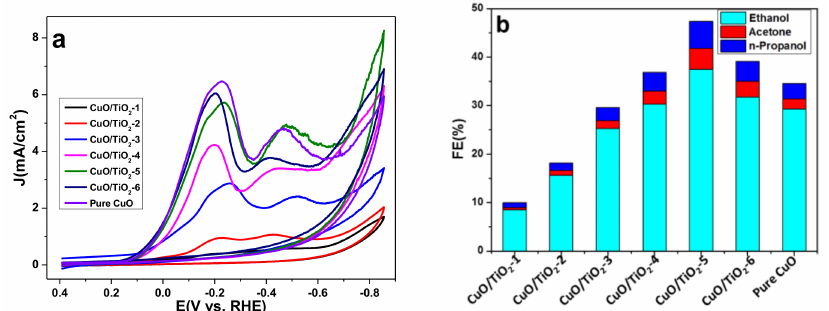
Figure 5. ( a ) CV curves of various CuO/TiO 2 catalysts over GCE in CO 2 -saturated 0.5 M KHCO 3 solution. Scan rate, 50 mV/s; ( b ) FEs for different products over various CuO/TiO 2 catalysts at − 0.85 V vs. RHE in CO 2 -saturated 0.5 M KHCO 3 aqueous